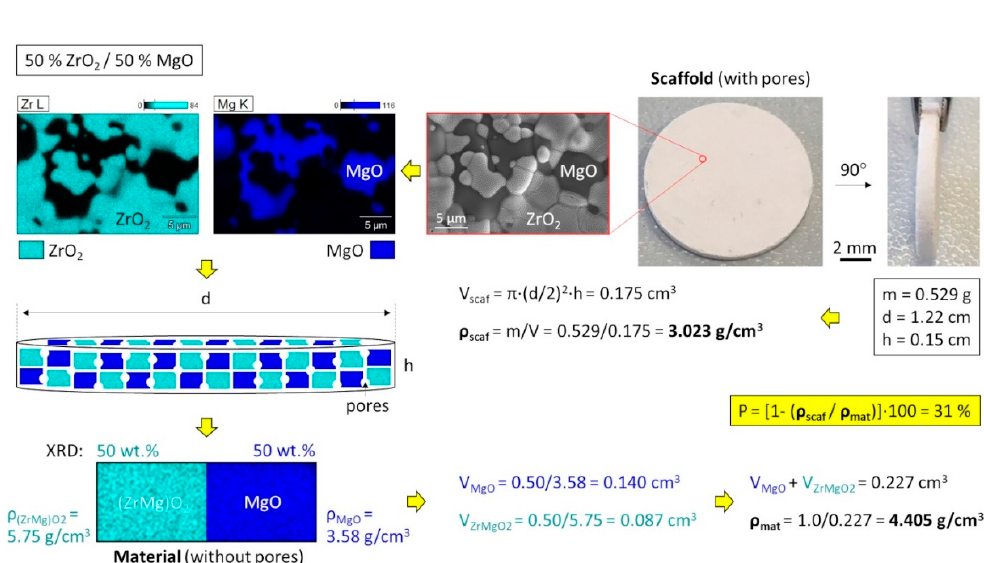
Figure 4. Calculation of the porosity for a two-phase system considering the crystallographic densities (caused by different atomic substitutions) and phase ratios exemplary shown for 50% ZrO 2 /50%